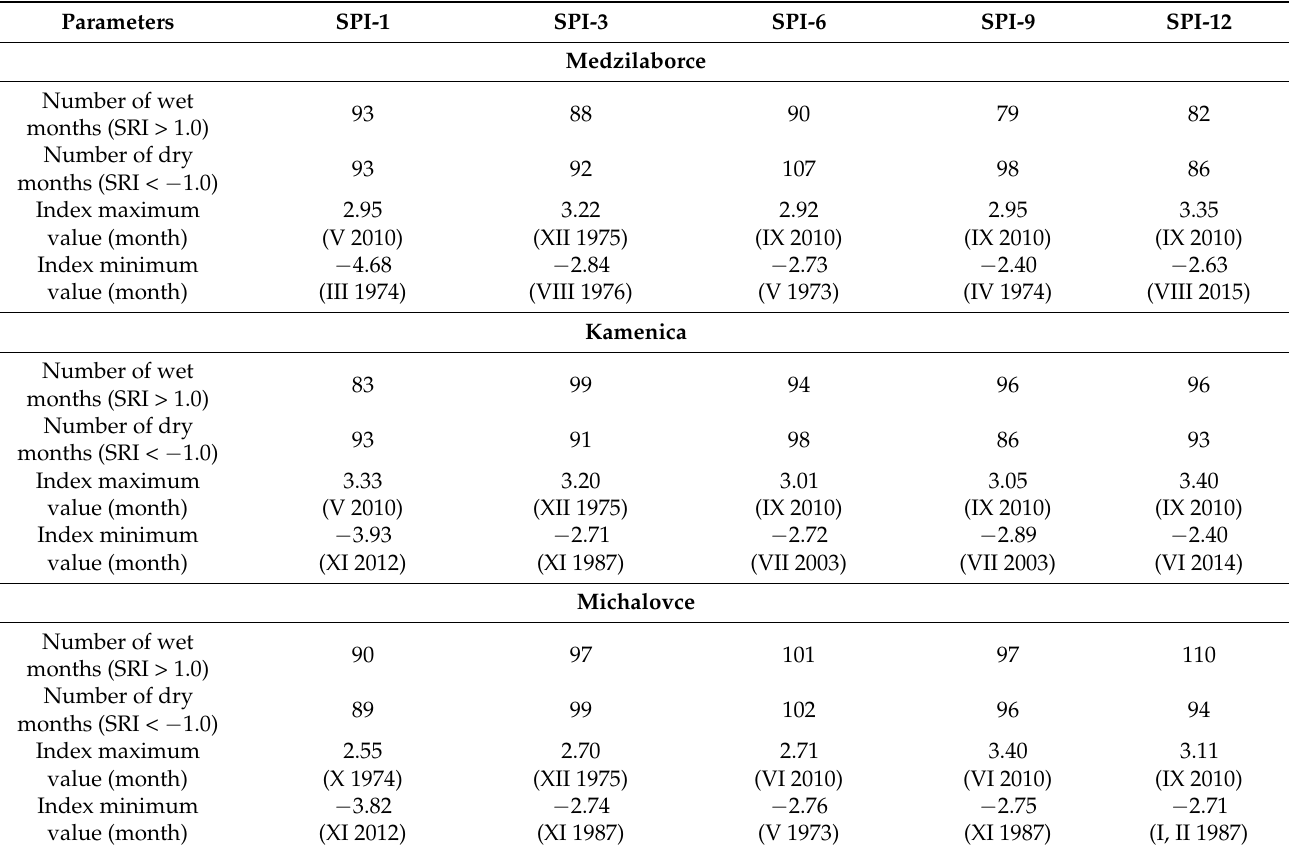
Table 5. SPI parameters over various time scales for the Medzilaborce, Kamenica, and Michalovce meteorological stations in the period